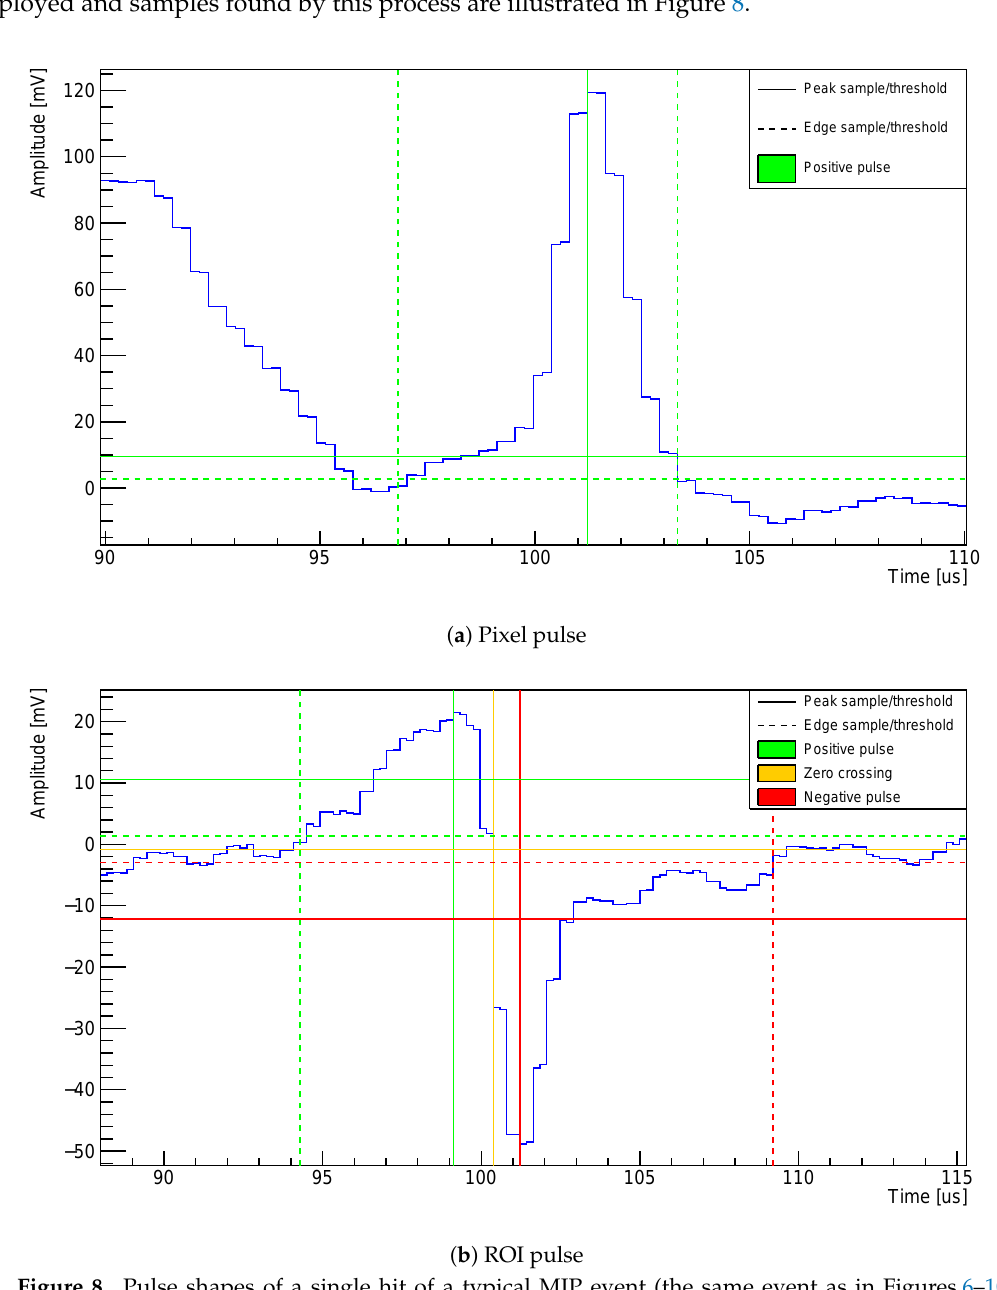
Figure 8. Pulse shapes of a single hit of a typical MIP event (the same event as in Figures 6–10). Superimposed are the thresholds of the pulse finding algorithm. Horizontal lines represent thresholds: solid are the minimum thresholds required to be crossed for a pulse to be detected, and dashed are the thresholds used to detect the pulse edges. Vertical lines represent the corresponding detected peak/edge samples. Color indicates a positive (green) or negative (red) pulse, or a zero crossing (yellow). Please note that the yellow zero-crossing threshold is not exactly zero as it is defined by the mean of the